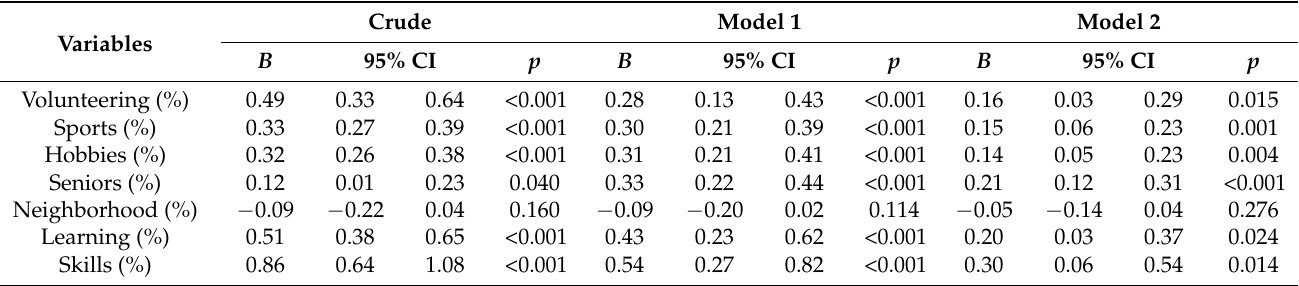
Table 2. The results of the linear mixed-effects model evaluation of the relationship between social participation and happiness with a score of 8 or higher at the municipal